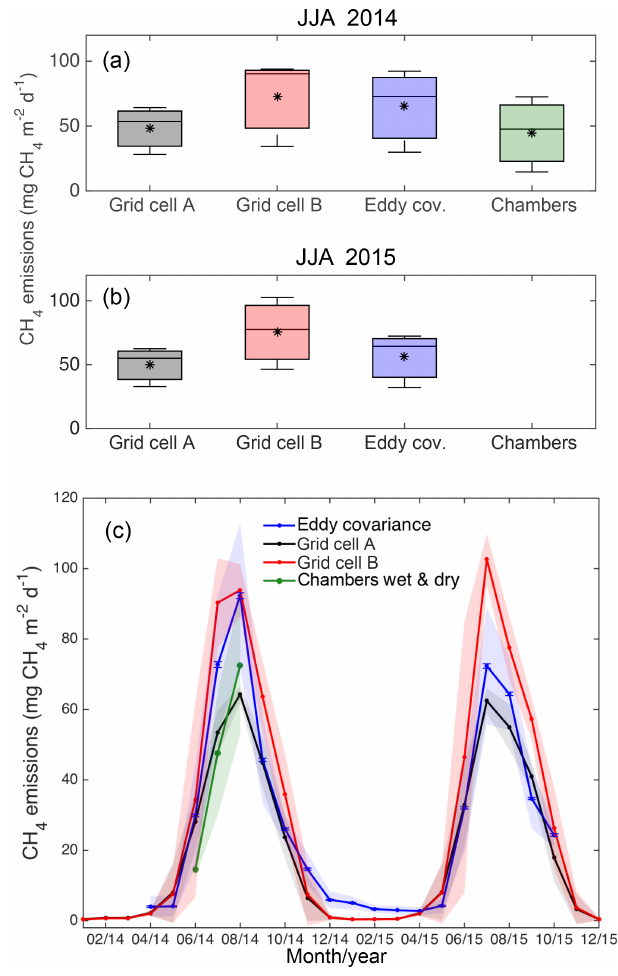
Figure 5. Box plot for summer (JJA) methane emissions from model grid cells A and B, eddy covariance and chamber flux mea- surements for (a) 2014 and (b) 2015 (without chamber flux mea- surements). The central horizontal line on each box is the median for each data set and whiskers are the minimum and maximum val- ues; (c) time series of monthly CH 4 emissions for 2014 and 2015 for grid cells A and B in the model, from eddy covariance as well as chamber flux measurements. Shaded areas depict 1 standard devia- tion of the monthly mean of each data set calculated from the daily resolution model output. Error bars in the EC fluxes are the uncer- tainty of the monthly averages of the gap-filled and quality checked signal.